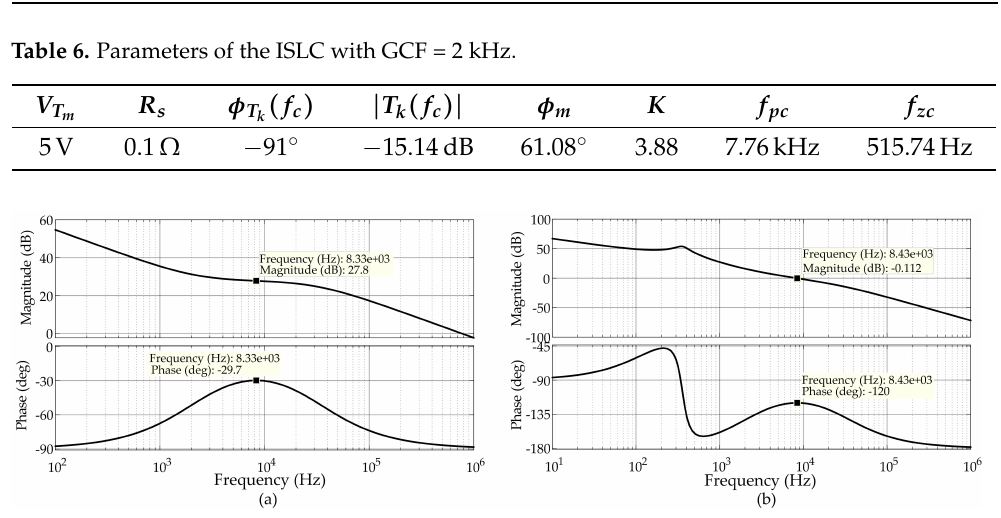
Figure 5. Bode plots for the ( a ) ISLC, T C , and ( b ) open-loop transfer function, T ol , with GCF = 8.33